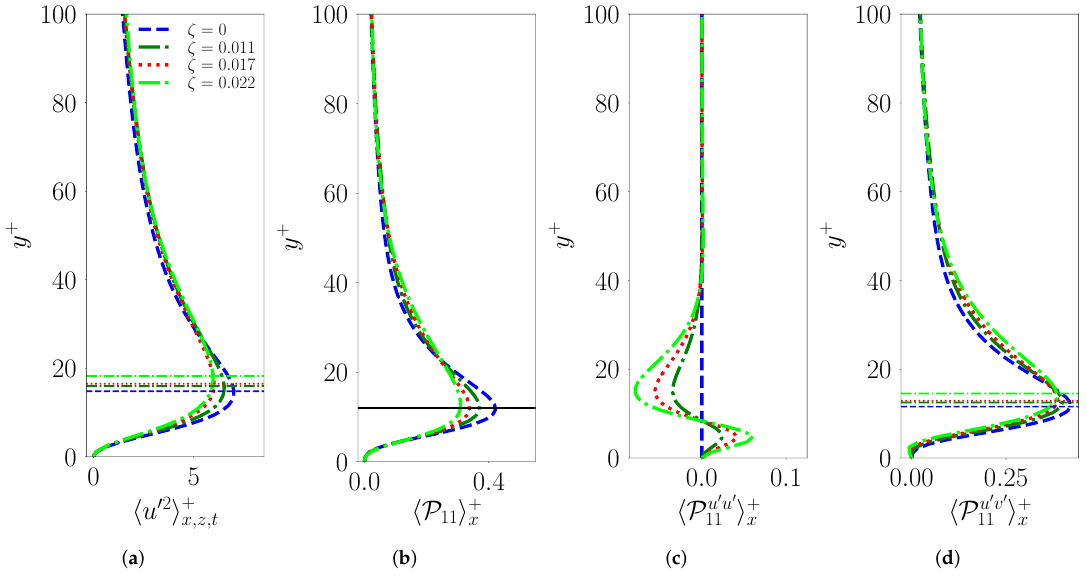
Figure 13. Inner scaled mean ( a ) streamwise variance and ( b ) production of streamwise variance, + P 11 x . We further split the streamwise production term into its dominant components, ( c ) (cid:104) P (cid:104) (cid:105) + P u (cid:48) v (cid:48) and ( d ) x . The horizontal lines correspond to height with maximum value of the statistics along 11 (cid:105) (cid:104) the